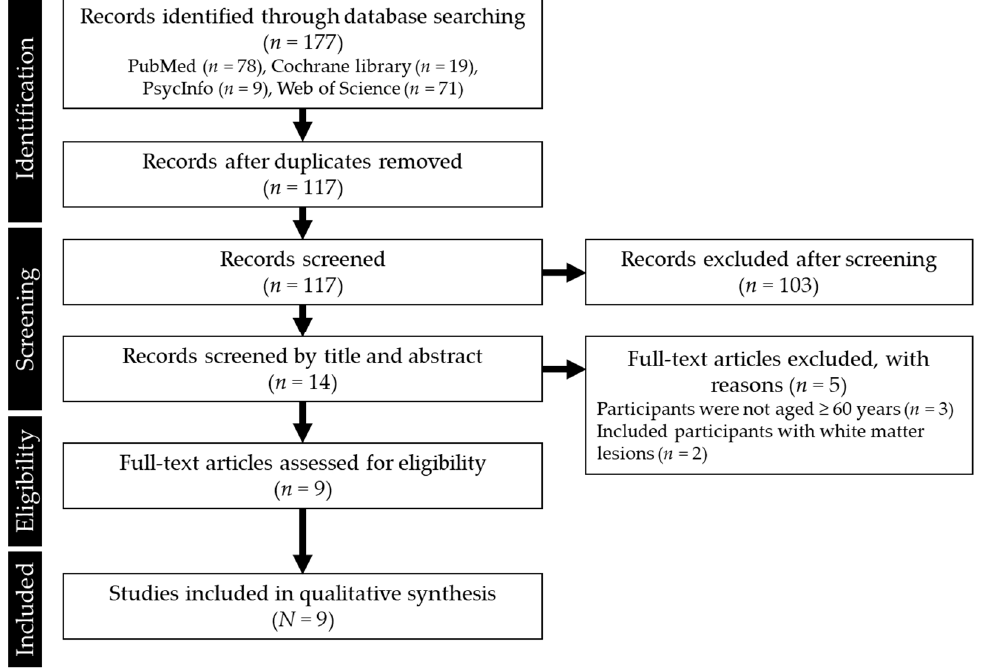
Figure 1. Study selection flow